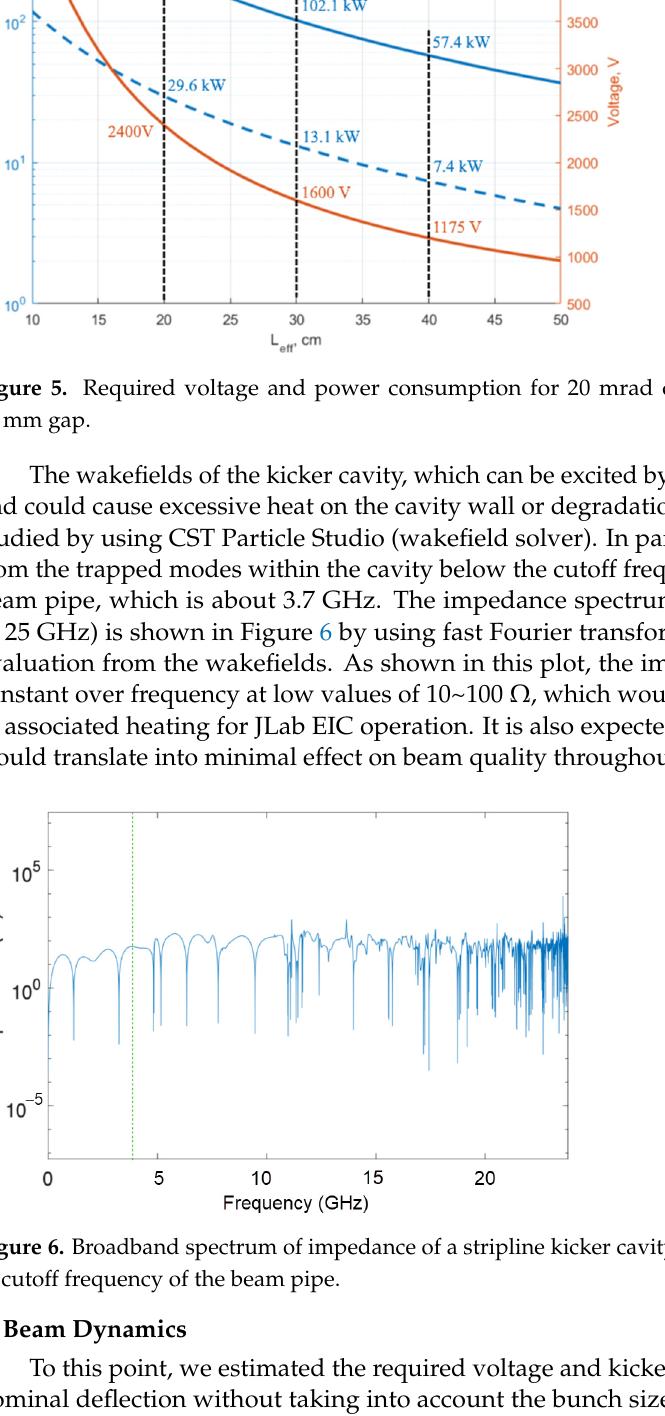
Figure 6. Broadband spectrum of impedance of a stripline kicker cavity. The green dotted line refers to cutoff frequency of the beam pipe.